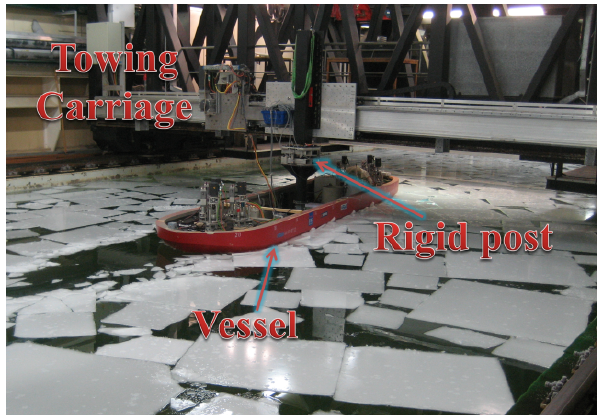
Figure 31: Towing experiment for the Arctic drillship at HSVA.